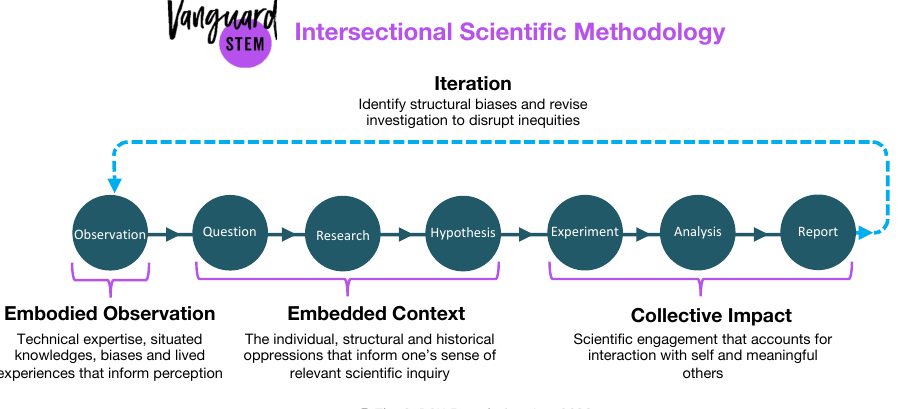
Figure 7. The #VanguardSTEM Intersectional Scientific Methodology. From left, circles represent the canonical scientific method. The purple brackets denote the ways that one’s cultural identities and experiences inform how they approach scientific inquiry as theorized in the present work. The cyan arrow represents the iterative nature of scientific experimentation and identifies an additional opportunity remove inequities in the process itself. As presented here, the influence of one’s identity and experience cannot be extricated from their scientific output and therefore presents an opportunity to improve scientific outcomes by being aware of the influence of embodied observation, embedded context and collective